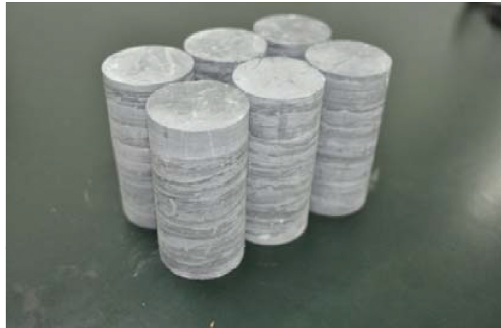
Figure 1: Parts of the